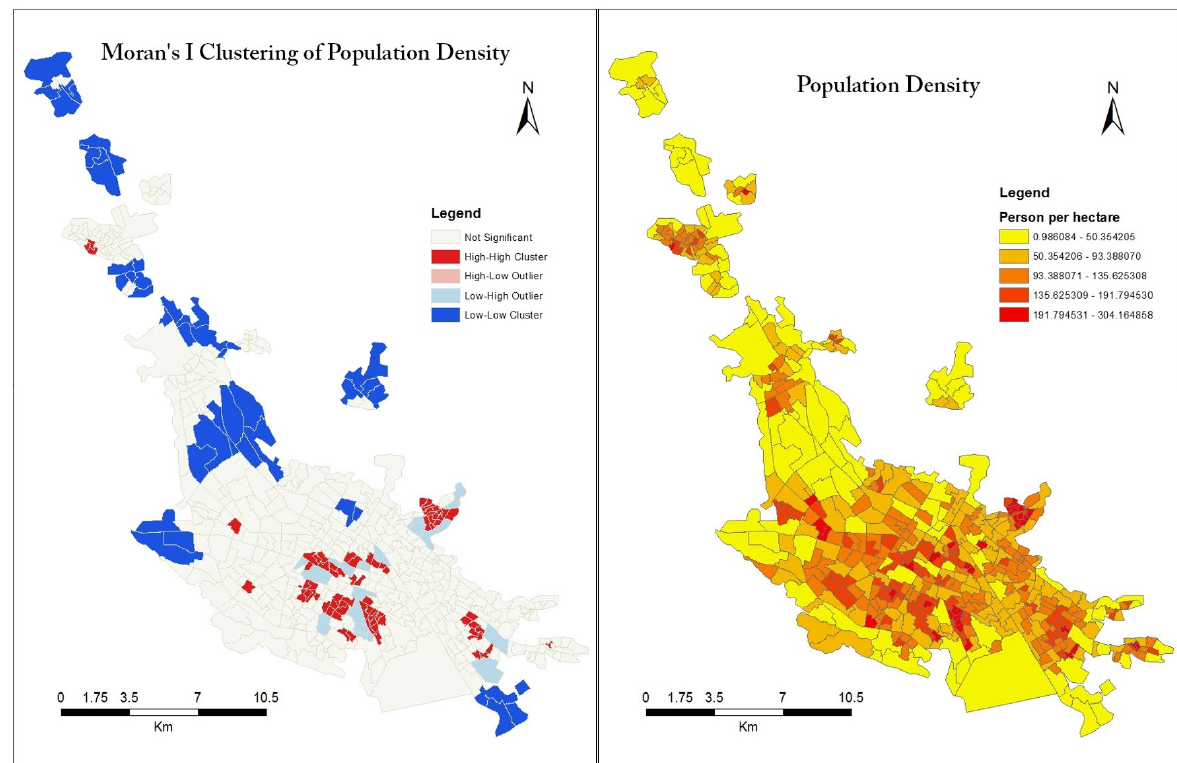
Figure 7. Population density distribution in the case of Shiraz.